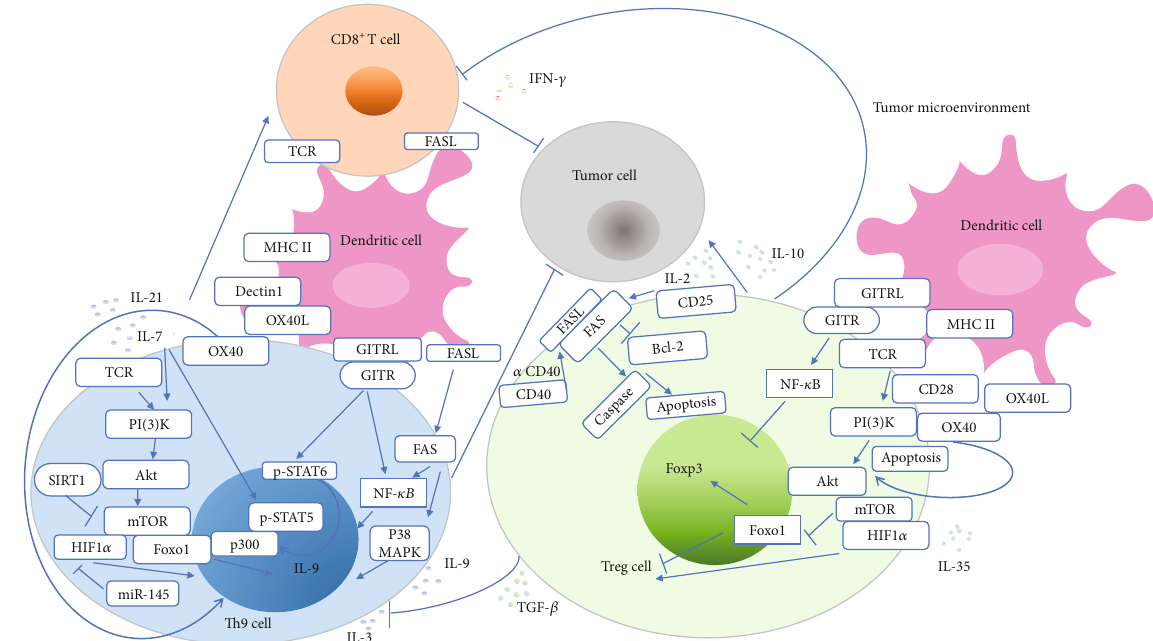
Figure 6: Signaling pathways critical for the roles and di ff erentiation of Th9 cells and Treg cells in solid tumor. Treg cells and Th9 cells receive signals through surface receptors such as TCR, CD28, and costimulatory molecules GITR and OX40, interacting with ligands on neighboring cells such as DCs and CD8 + T cells. Engagement of the TCR complex and of the coreceptor CD28 activates the phosphoinositide 3-kinase- (PI (3) K-) Akt and mTOR pathways, which inactivate Foxo1. Expression of the Akt-insensitive Foxo1 mutant depletes tumor-associated activated Treg (aTreg) cells and activate CD8 + T cell response in the mammary tumor model. In the mouse melanoma model, PI (3) K- Akt-mTOR signaling is activated by IL-7, which results in nuclear accumulation of Foxo1 and activation of STAT5 that binds to the p300 promoter to induce di ff erentiation of Th9 cells and production of IL-9. OX40/OX40L engagement activates the AKT-mTOR pathway, which induces phosphorylation and nuclear exclusion of Foxo1 to inhibit Foxp3 induction. Activation of OX40 induces Treg cell apoptosis and increases the CD8 + T cell/Treg cell ratio. OX40L can be induced by the dectin-1 signaling pathway. Dectin-1 activates DCs